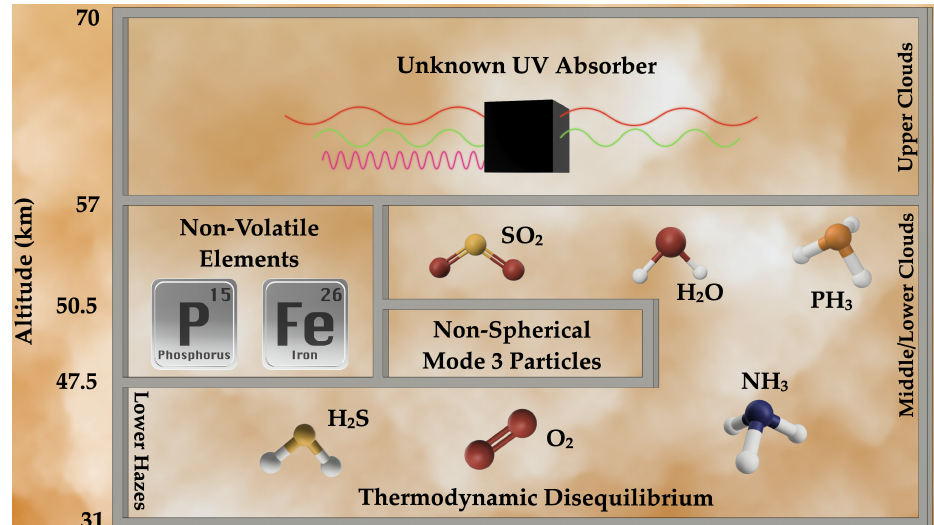
Figure 1. Unexplained Venus atmospheric anomalies in the clouds that could be targets of a dedicated prolonged scientific investigation by an aerial platform.